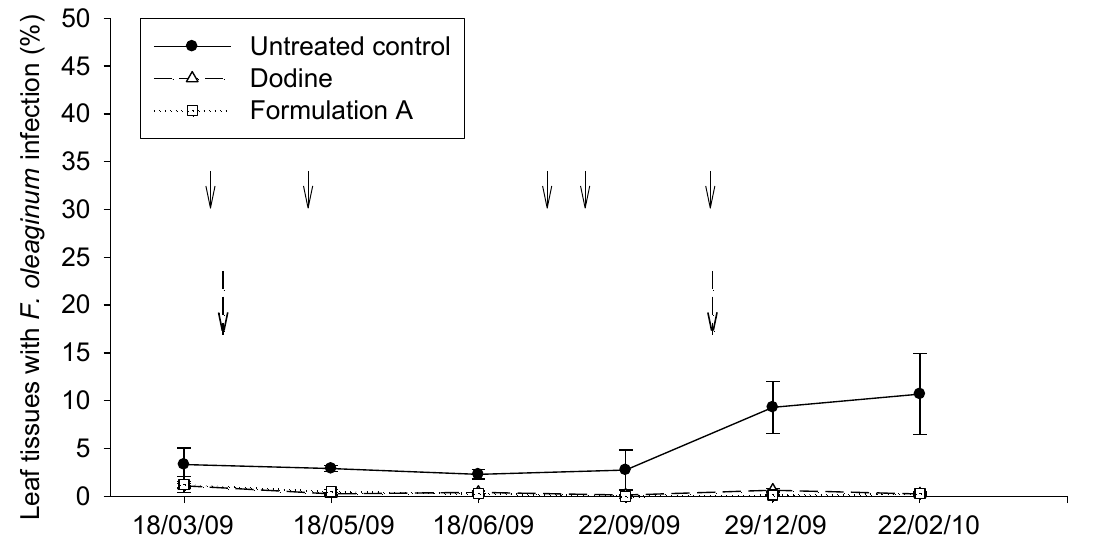
Figure 1. Mean proportions of olive leaf tissues with F. oleagineum infection in the cultivar Gentile di Chieti. Treatments with Formulation A and dodine are